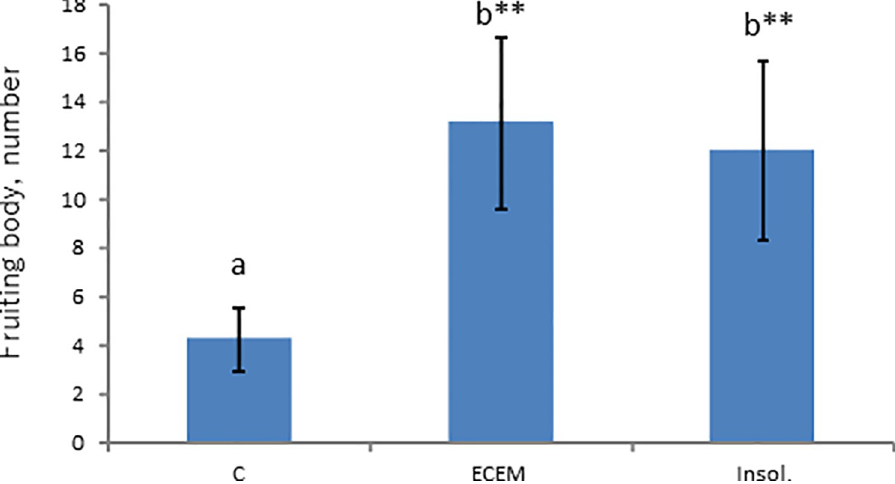
Fig 4. Activity of fruiting body formation was recovered in the residual fraction. C (Control without ECEM); ECEM (10% ECEM); Insol (Insoluble residue). �� : Significant difference in comparison to the Control by Steel test (p < 0.01), a, b: different letters show significant difference by Steel-Dwass test(p <